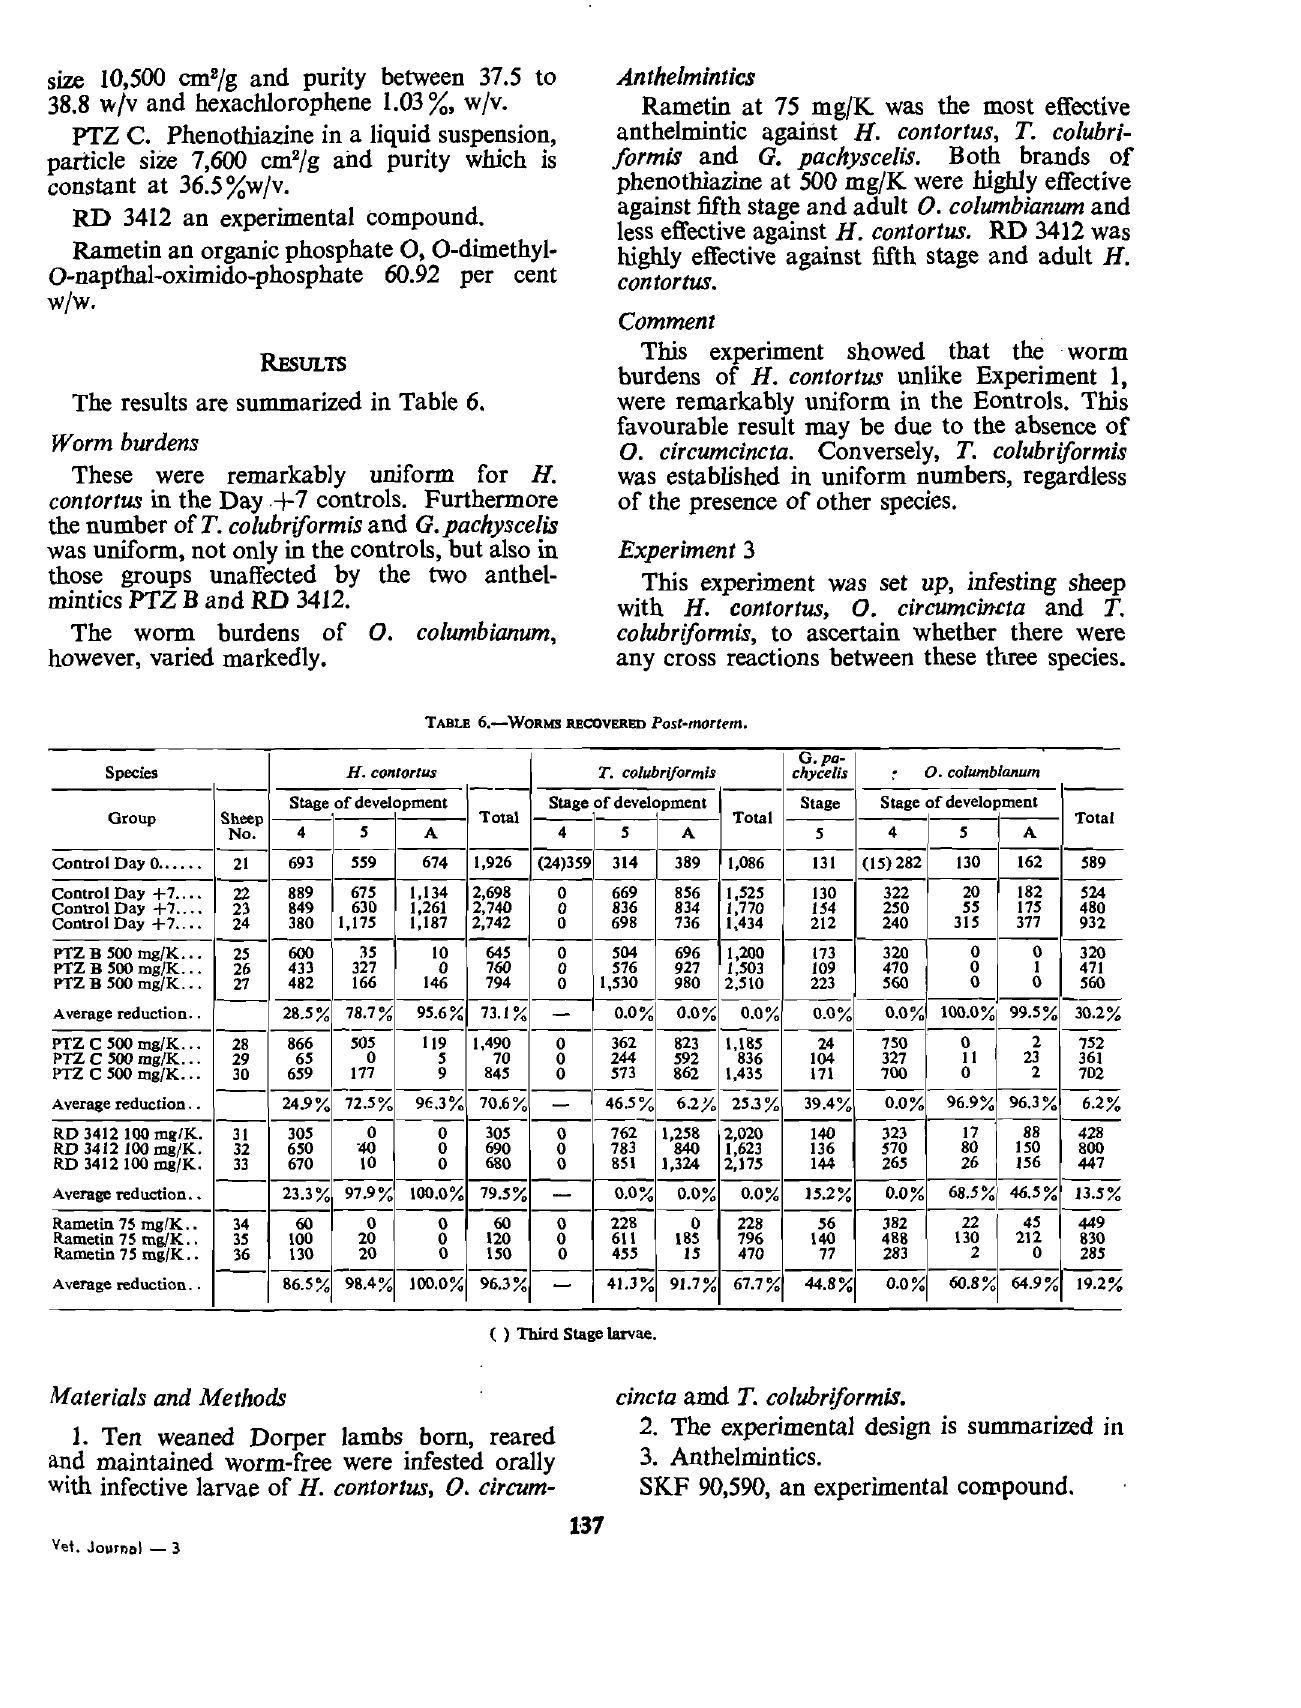
TABLE 6.-WORMli RECOVERED